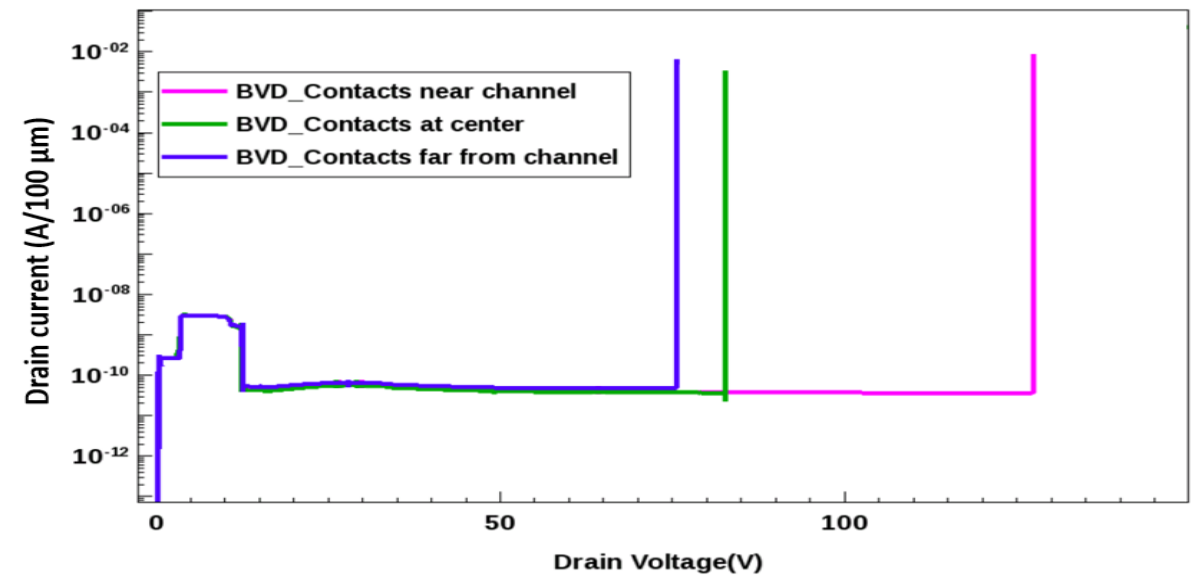
Figure 9. Simulated breakdown voltage comparison with different metal positions.